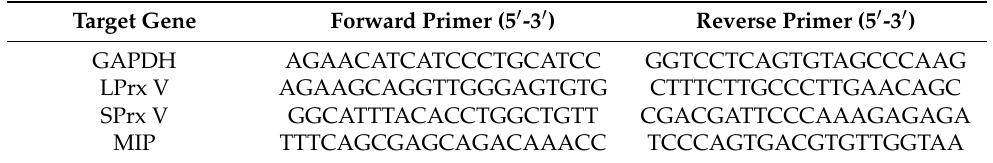
Table 1. Sequence of qPCR(quantitative real time PCR)